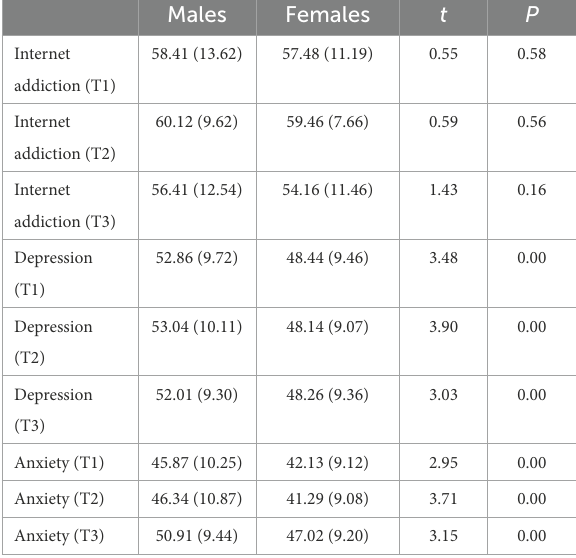
TABLE 2 Analysis of sex differences in depression, anxiety, and Internet addiction. Males Females t